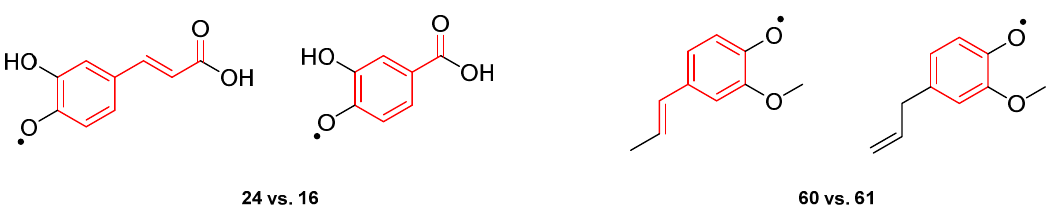
Figure 8. Comparison between caffeic acid ( 24 ) and protocatechuic acid ( 16 ) and between isoeugenol ( 60 ) and eugenol ( 61 ).